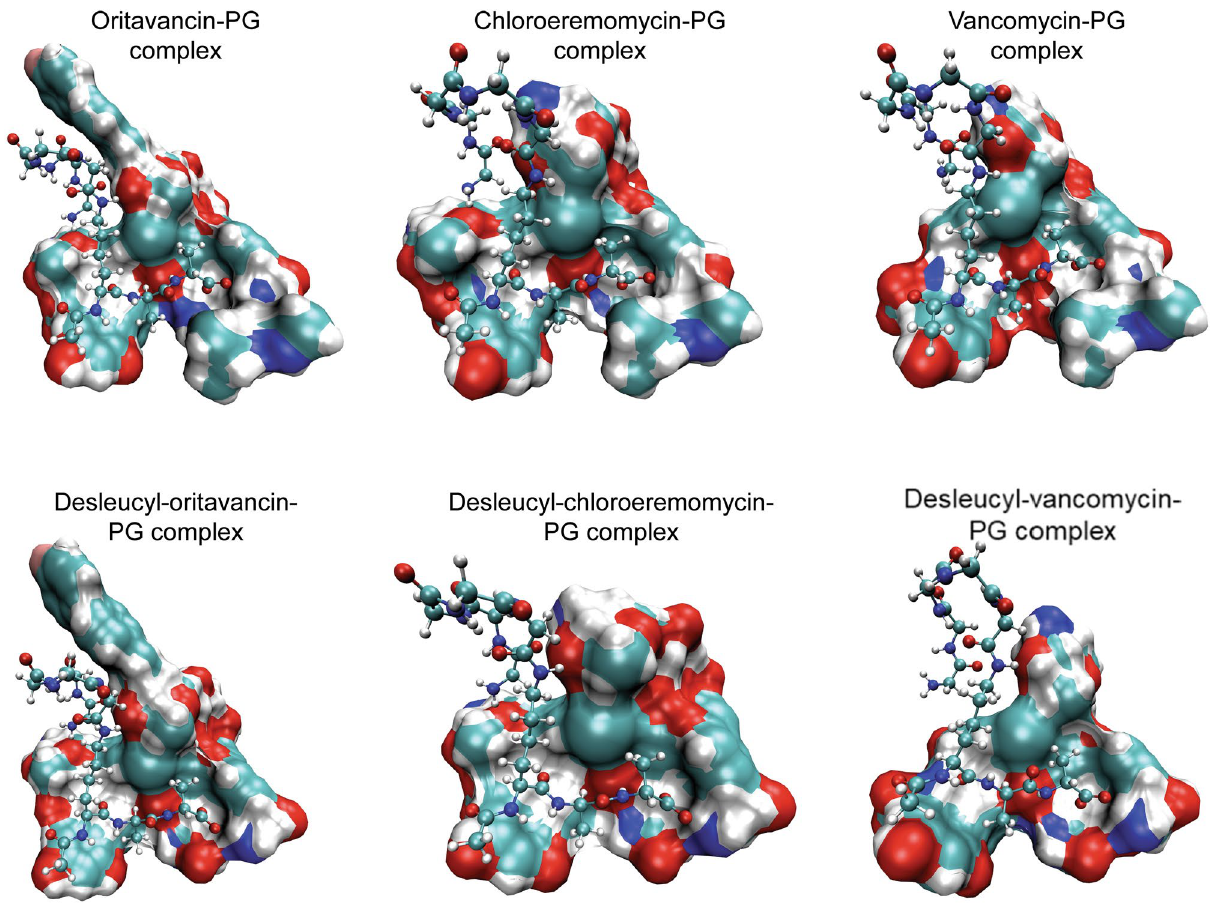
Figure 2. MD simulation model structures of the glycopeptide- and desleucyl-glycopeptide–PG complexes. The glycopeptides (top) and desleucyl-glycopeptides (bottom) are shown as a visual molecular dynamics (VMD) 45 solid surf model using a probe radius of 1.4 Å , while the CPK model represents the PG (Fig. 1d). The glycopeptide–PG complexes (top) include [ 19 F]oritavancin–PG complex (top left), chloroeremomycin–PG complex (top middle) and vancomycin–PG (top right). The desleucyl-glycopeptide–PG complexes (bottom) include desleucyl[ 19 F]oritavancin–PG complex (bottom left), desleucyl-chloroeremomycin–PG complex (bottom middle), and desleucyl-vancomycin–PG (bottom right).